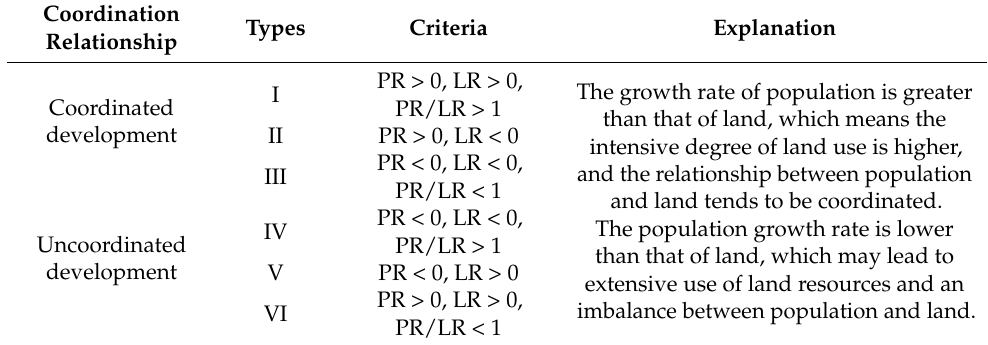
Table 2. Types of coupling relationship between urban population and land.